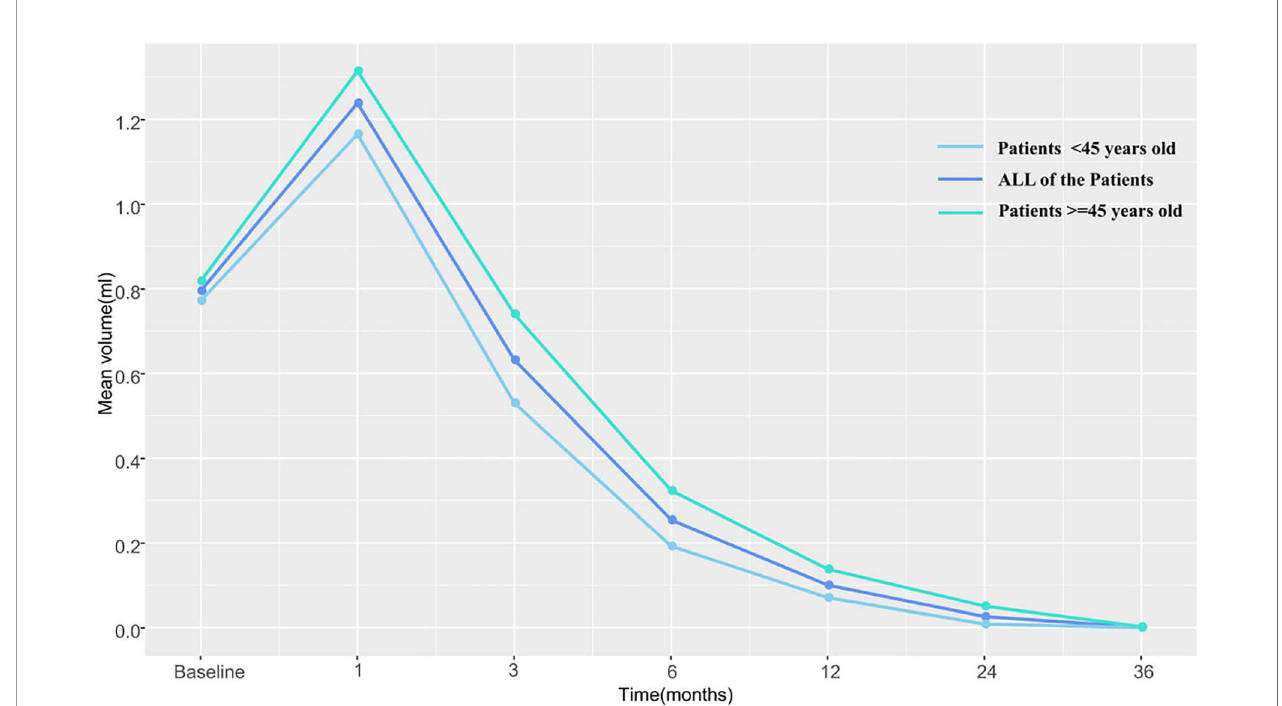
FIGURE 2 | The changes in mean tumor volume at each follow-up point in both age